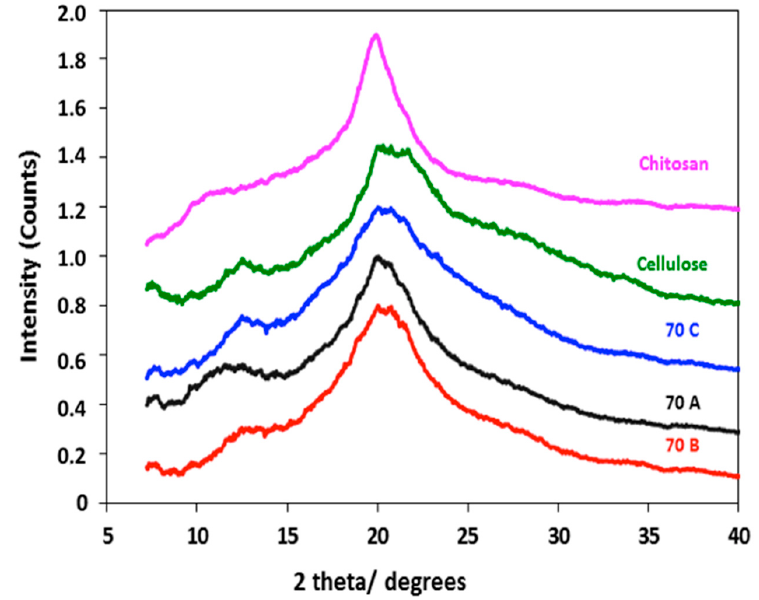
Figure 4. XRD diffraction patterns of chitosan, regenerated cellulose, 70A , 70B and 70C chitosan- cellulose hydrogel